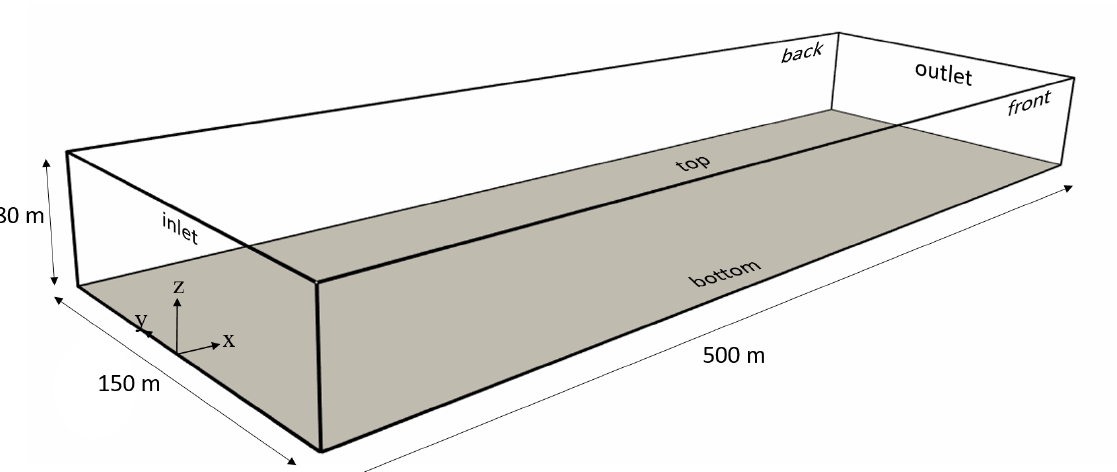
Figure 9. Sketch of the domain used for the simulation of the application example. Particles were injected at x = 50 m at three different lateral points y = [ − 0.25, 0, 0.25] m at a height of 1.5